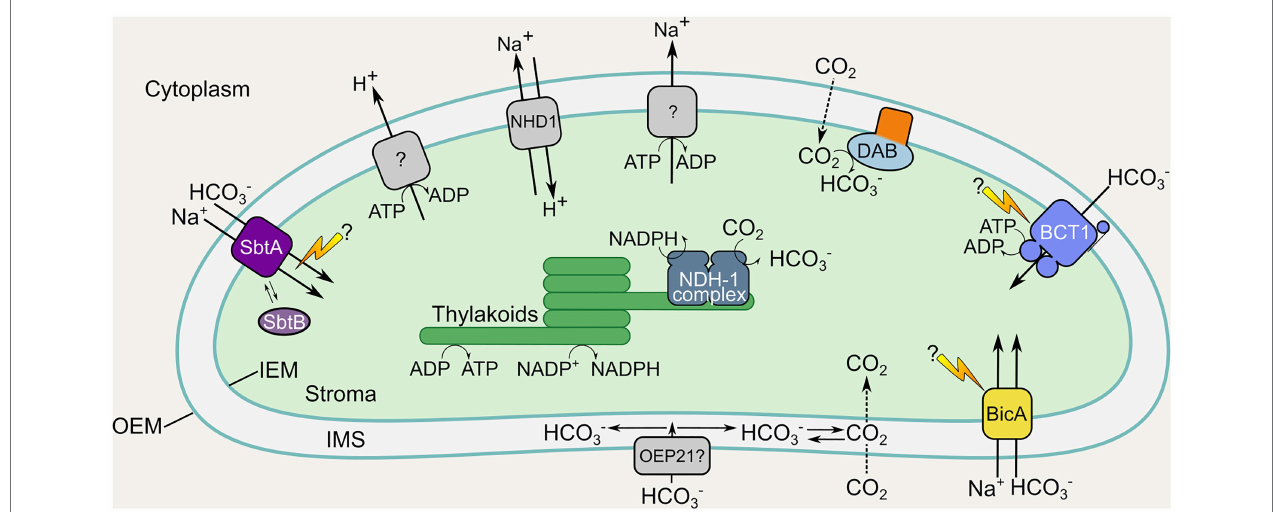
FIGURE 2 | Location and function of inorganic carbon uptake systems in a proposed chloroplastic CCM. Inorganic carbon uptake components from cyanobacteria and proteobacteria proposed for engineering into the chloroplast IEM and thylakoids of terrestrial C 3 plants. Membrane transporters and vectorial CO 2 -HCO 3 − conversion complexes from cyanobacteria and proteobacteria are shown in color (see Figure 1 ; Table 1 ). Additional native chloroplastic systems which may support the required energetics and facilitation of active HCO 3 − uptake (including Na + and H + extrusion systems and the NHD1 Na + /H + antiporter) are shown in gray. The cyanobacterial HCO 3 − transporters BicA and SbtA, as well as the ATP-driven BCT1 complex are targeted to the IEM may require unknown activation processes, indicated by lightning bolts. Note the added complexity of the multi-subunit BCT1 complex requiring protein components in the inter-membrane space (IMS), IEM, and stroma. The cyanobacterial vectorial NDH-1 complex has been suggested on the thylakoid membrane as it likely requires energization by components of the photosynthetic electron transport chain (ETC). The proteobacterial vectorial DAB complex is tentatively depicted on the IEM, but, alternatively, co-localization with the ETC on the thylakoid membrane may be favorable for its energization. The broad-specificity channel protein OEP21 on the outer-envelope membrane (OEM) is depicted as a putative access point for cytoplasmic HCO 3 − uptake into the IMS. Individual transporter proteins are as listed in Table 1